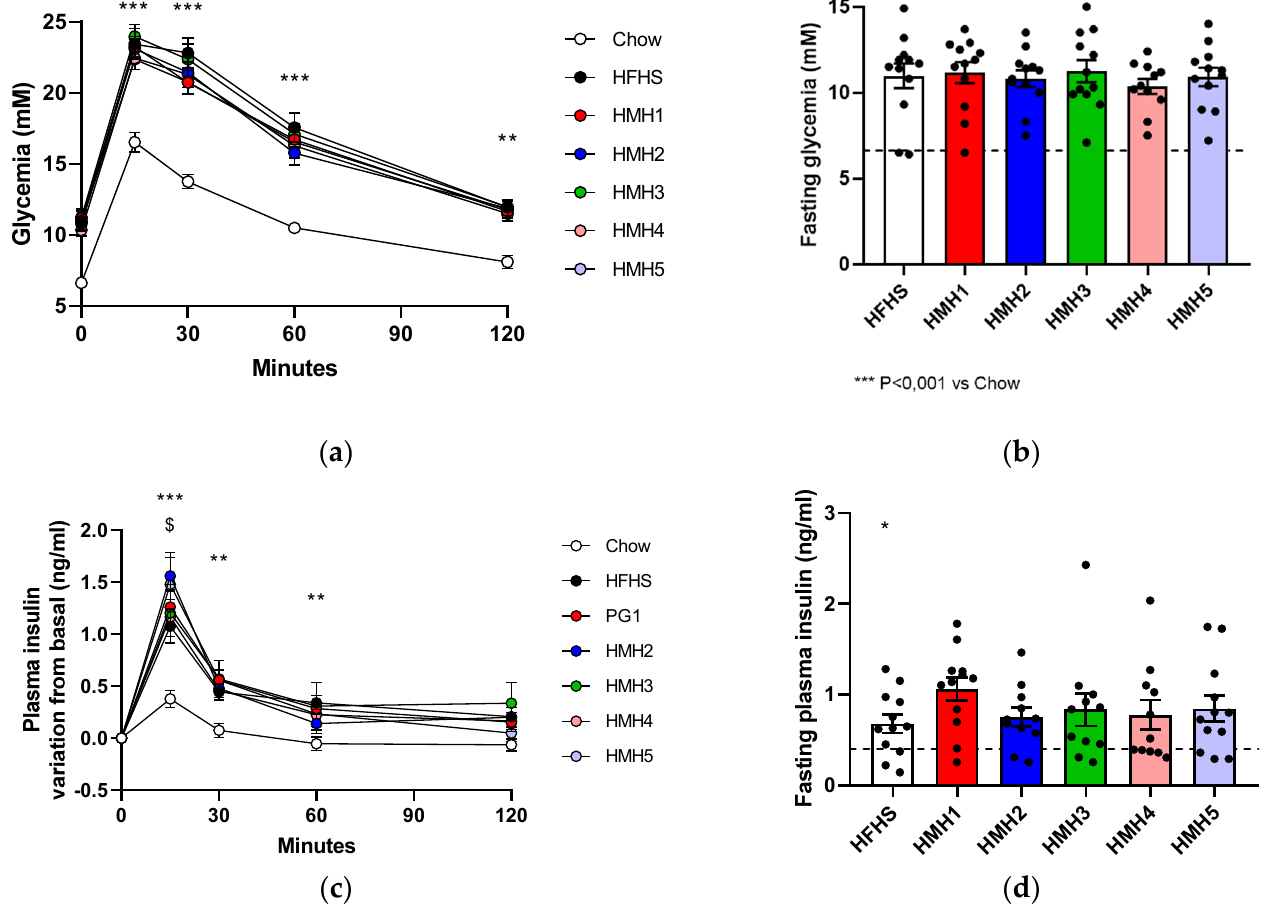
Figure 4. Impact of HMHs’ supplementation in mice fed with HFHS on glucose tolerance during OGTT. ( a ) Glycemia curve as a function of time after administration of dextrose (1 g/kg of body weight), ( b ) Blood glucose concentrations were measured at t = 0 after 12 h of fasting, ( c ) Insulin variation curve product as a function of time, and ( d ) Insulin concentrations were measured at t = 0 after 12 h of fasting. * p < 0.05 Chow vs. HFHS, ** p < 0.01 Chow vs. HFHS, *** p < 0.001 Chow vs. HFHS, $ p < 0.05 HFHS vs. HMH2.